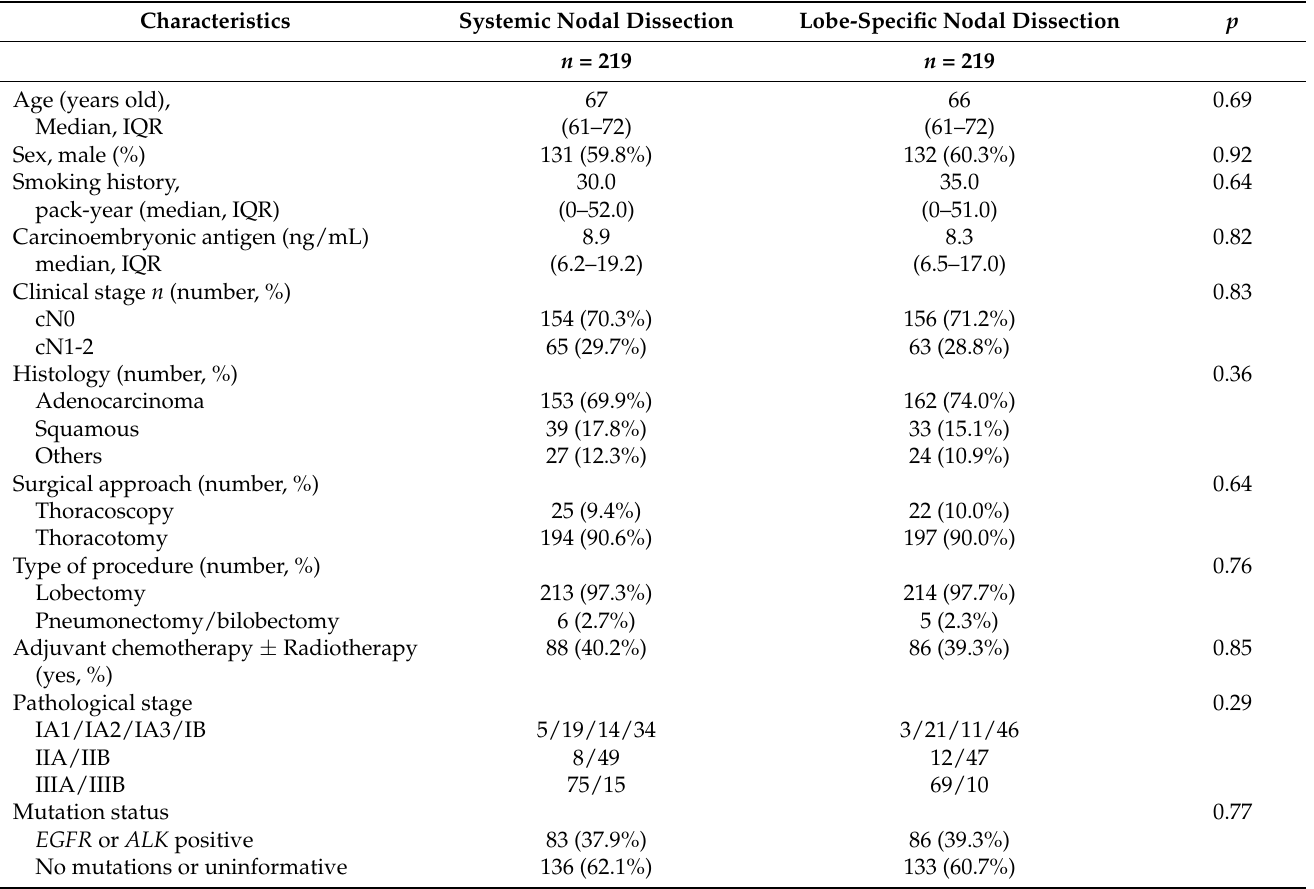
Table 2. Clinicopathological characteristics after propensity